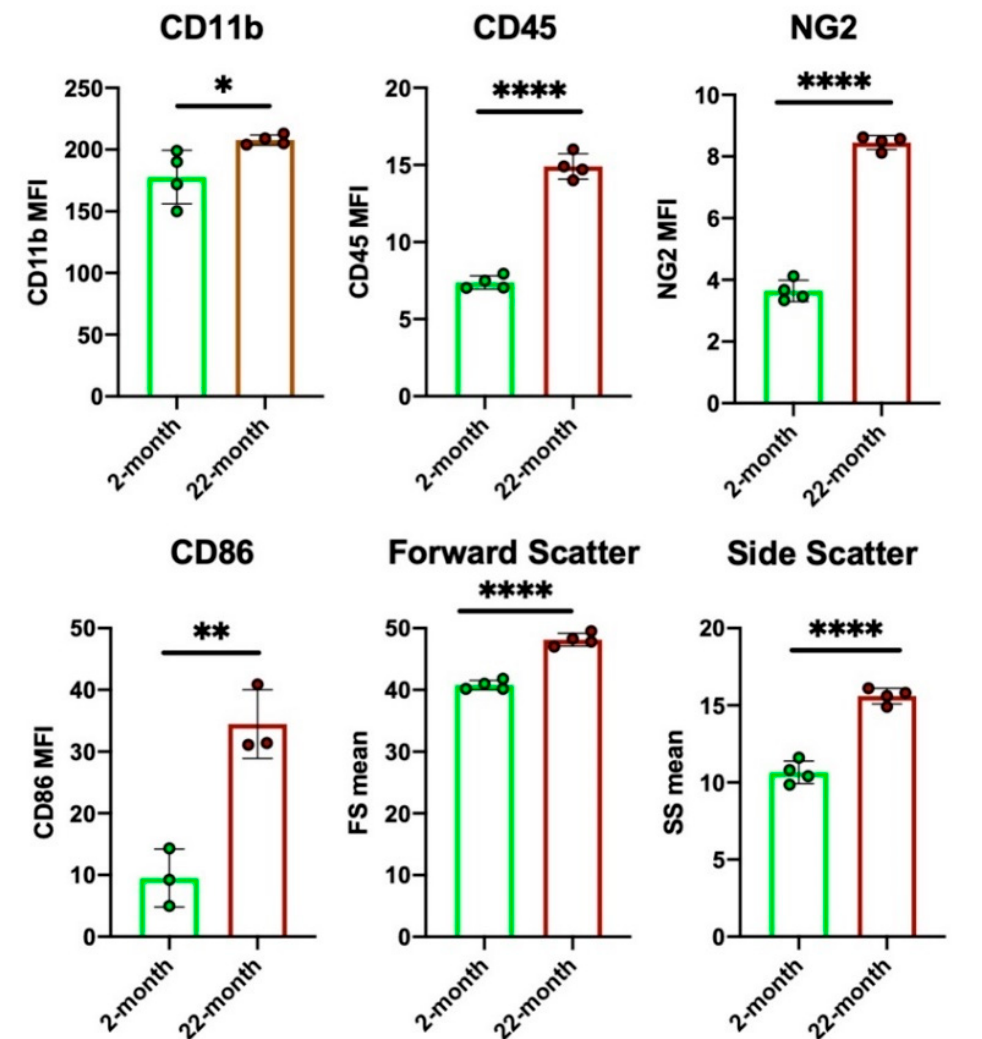
Figure 5. Senescent changes of microglia, as revealed by flow cytometry. Brain cells in the prefrontal cortices of 2- and 22-month-old male Wistar rats were enzymatically dissociated and subjected to flow cytometry analyses. Microglial cells in the 22-month-old rat brains showed higher CD11b, CD45, NG2, and CD86 expression than those in the 2-month-old rat brains. Furthermore, the senescent microglia had higher forward scatter (FS) and side scatter (SS) values, implying that they had larger and more granular somata than those in the young rat brains. Data are expressed as the mean ± SD. Unpaired two-tailed t-test. * p < 0.05, ** p < 0.01, **** p < 0.0001. Detailed information on the methodology is presented elsewhere [96].